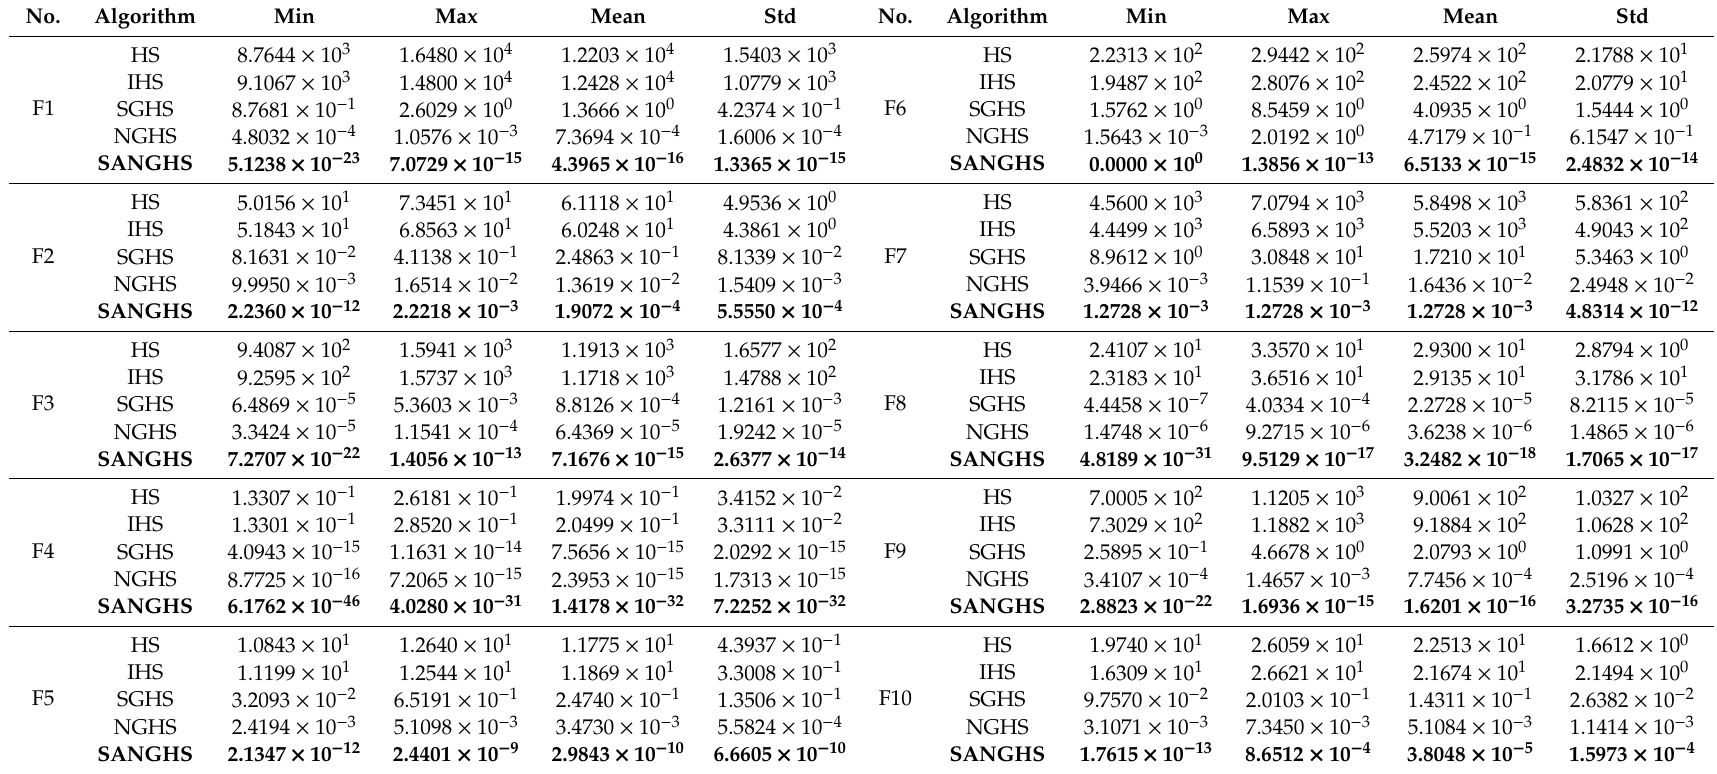
Table 4. Experimental results of five algorithms for 10 problems with D =